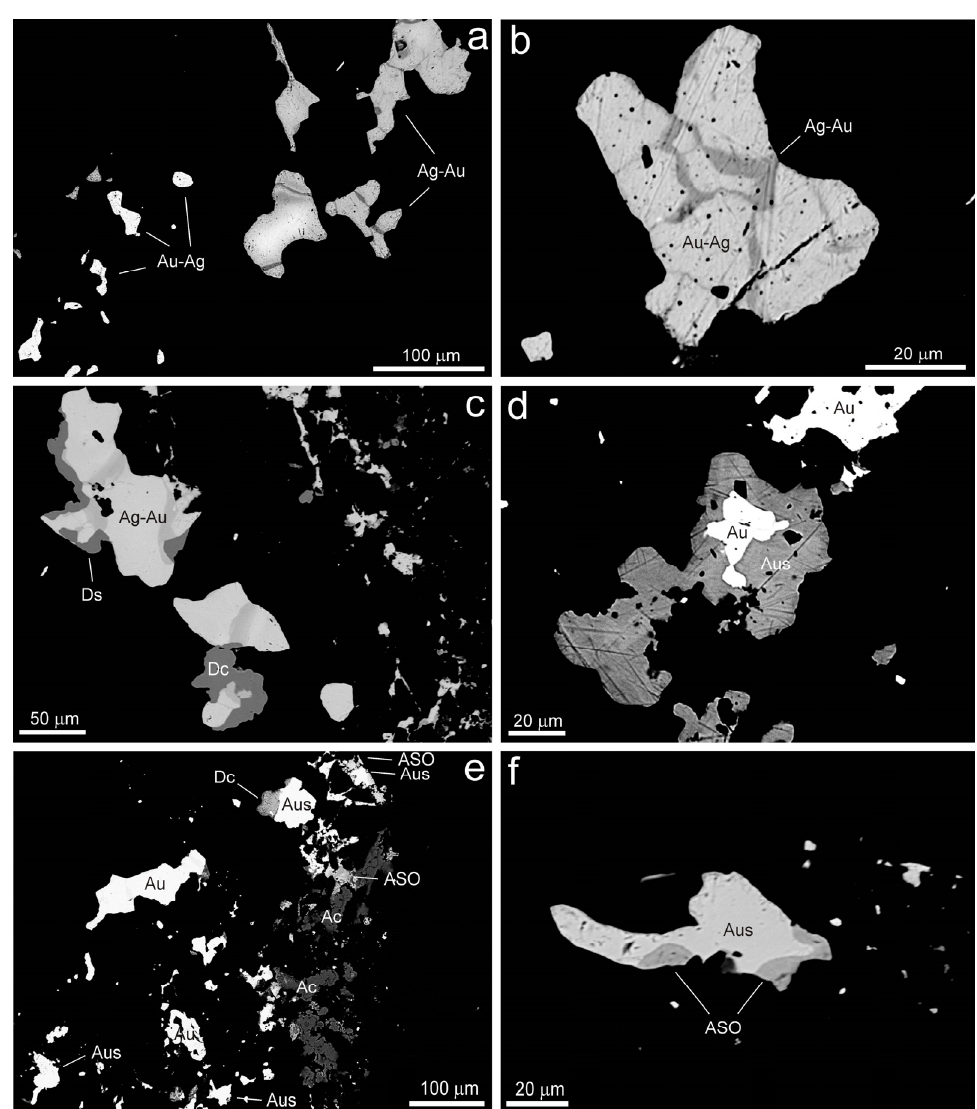
Figure 7. Textures of gold-rich portions of the studied Au-bearing vein in BSE images: ( a ) A group of gold grains with contrasting fineness. The central grain shows diffuse internal zonality with increasing Ag towards the margin and dark veinlets richest in Ag. ( b ) Veinlets of Ag-rich Ag-Au alloy (Ag-Au) cutting the Au-rich Ag-Au alloy (Au-Ag). ( c ) Zoned Ag-Au alloy partly rimmed by dyscrasite (Dc). ( d ) Gold grain (Au) partly replaced by aurostibite (Aus). ( e ) A group of gold grains (Au) partly or completely replaced by aurostibite (Aus), an unnamed (Au,Ag)-Sb oxide (ASO) and acanthite (Ac). ( f ) Grain of aurostibite (Aus) partly replaced by an unnamed (Au,Ag)-Sb oxide (ASO).